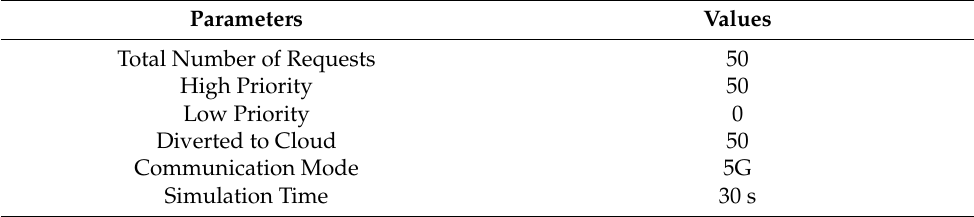
Table 6. Cloud scenario 3.